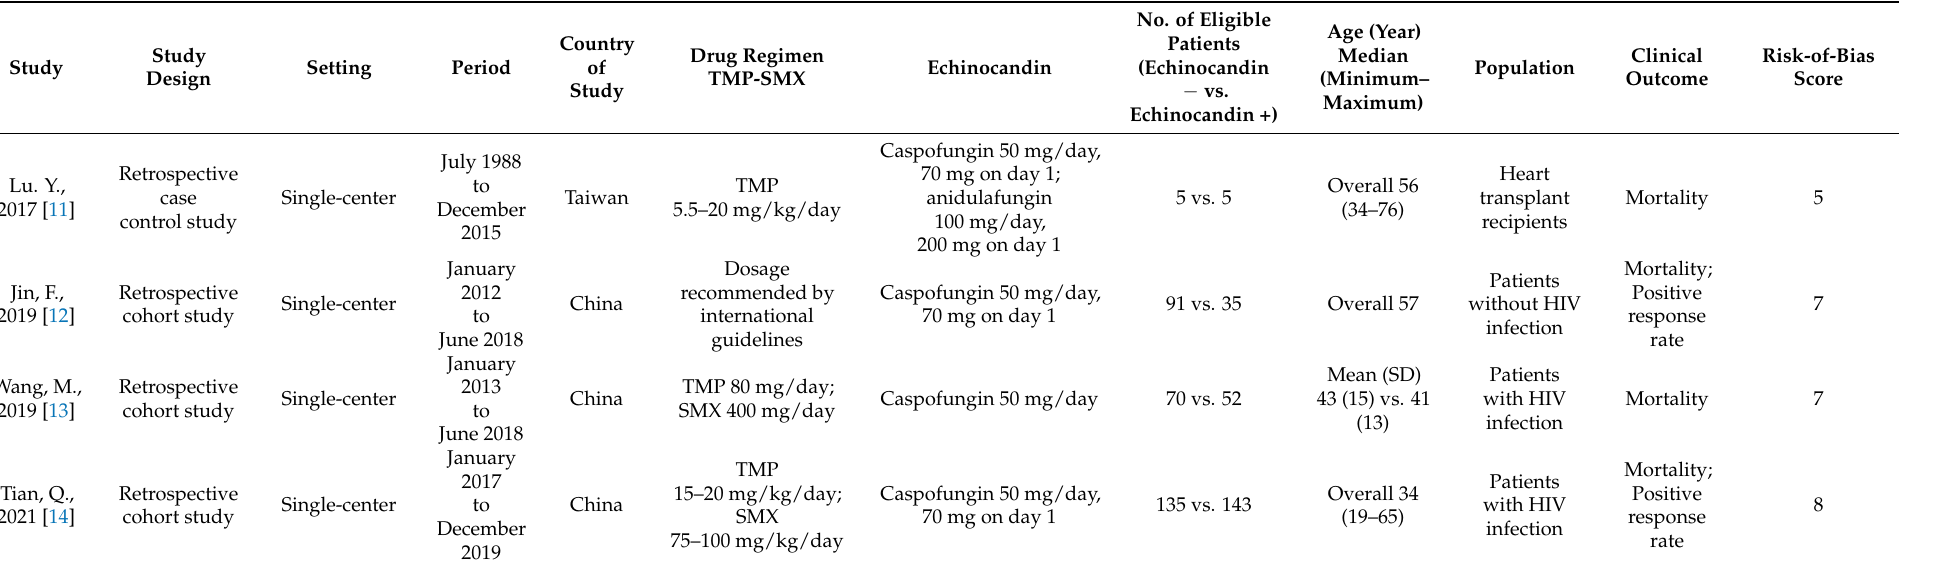
Table 1. Characteristics of the studies included in the